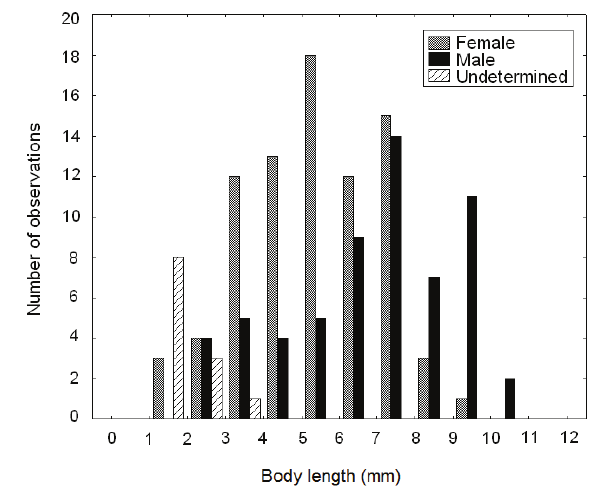
Figure 4. Body-size frequency distribution obtained from a total of 154 specimens (81 females; 61 males and 12 of undefined sex) of Quadrivisio lutzi .